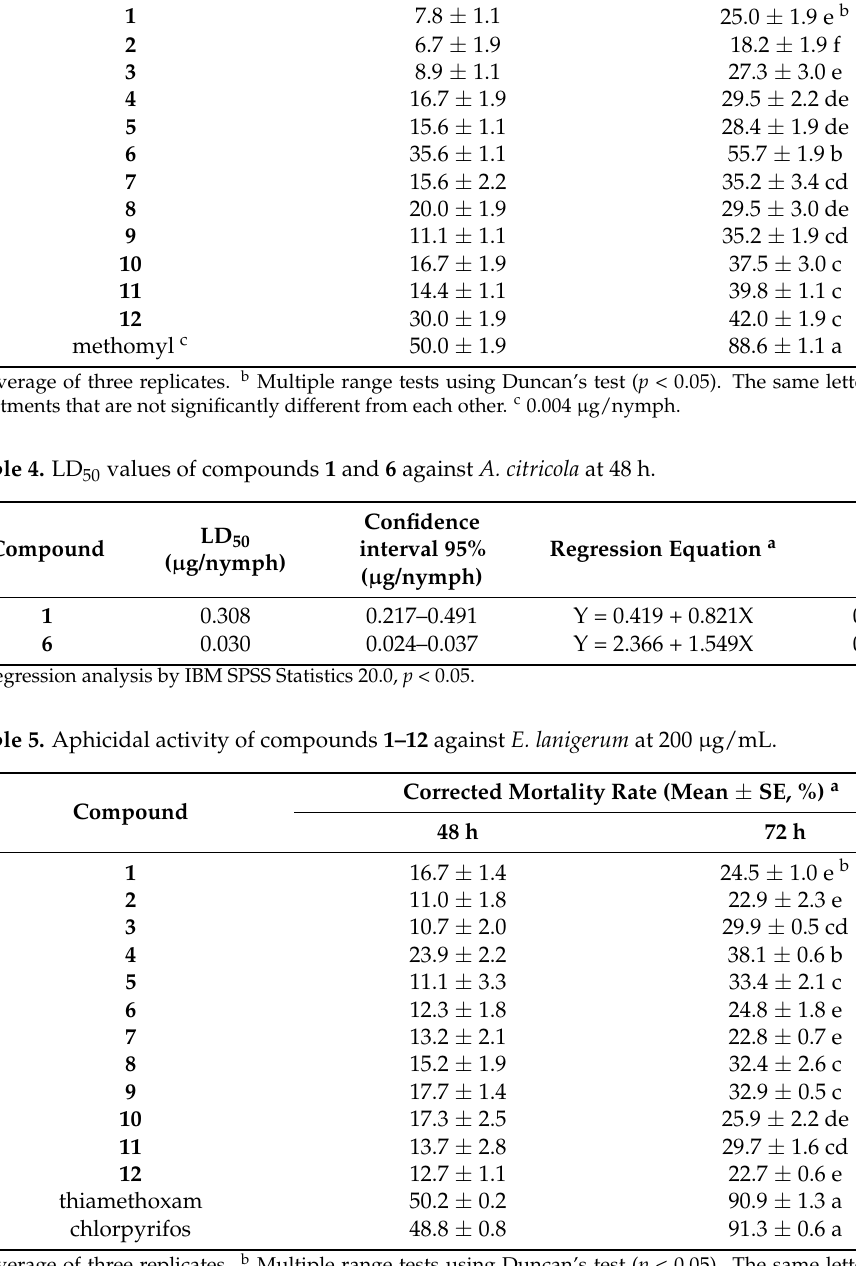
Table 3. Aphicidal activity of compounds 1–12 against apterous adults of A. citricola at 0.04 µ g/nymph.